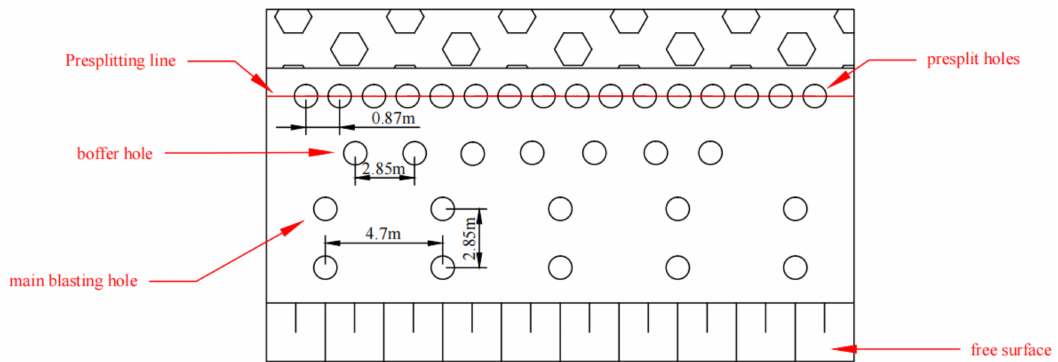
Figure 5. Schematic diagram of gun hole